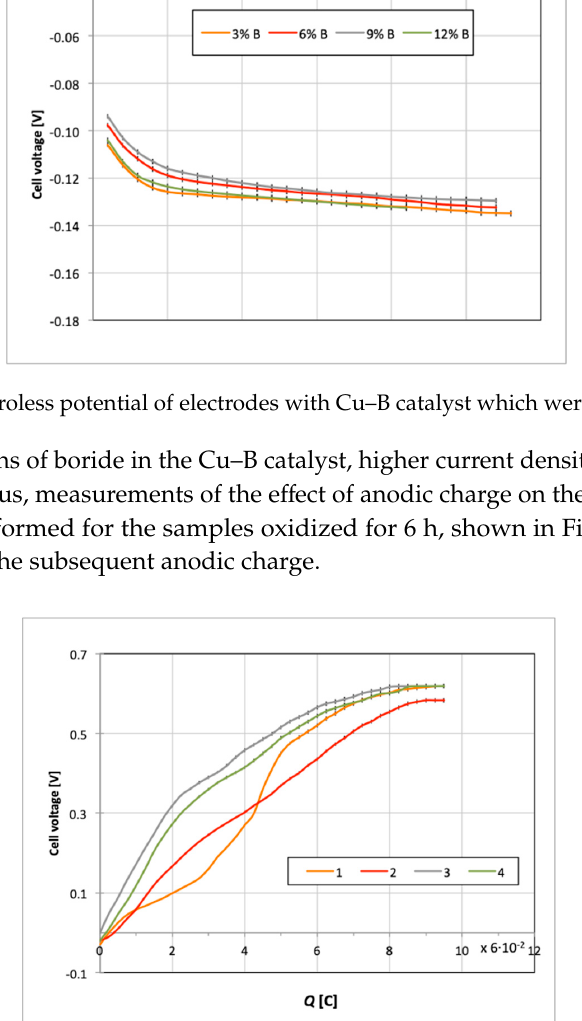
Figure 6. Influence of anodic charge on the catalytic activity of Cu–B alloy containing 3% of B.